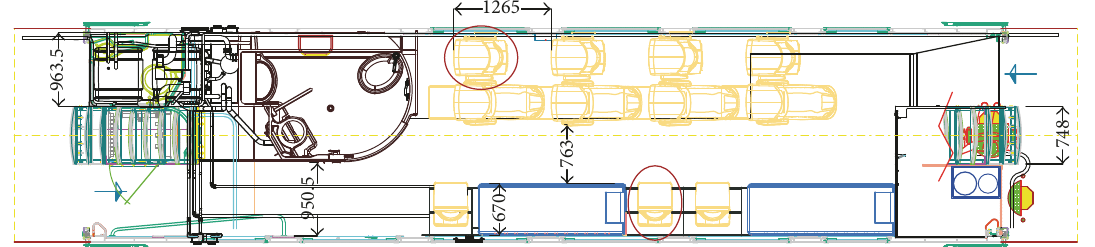
Figure 20: Position of the sensors (red circles) on the ground floor in the coach central part.